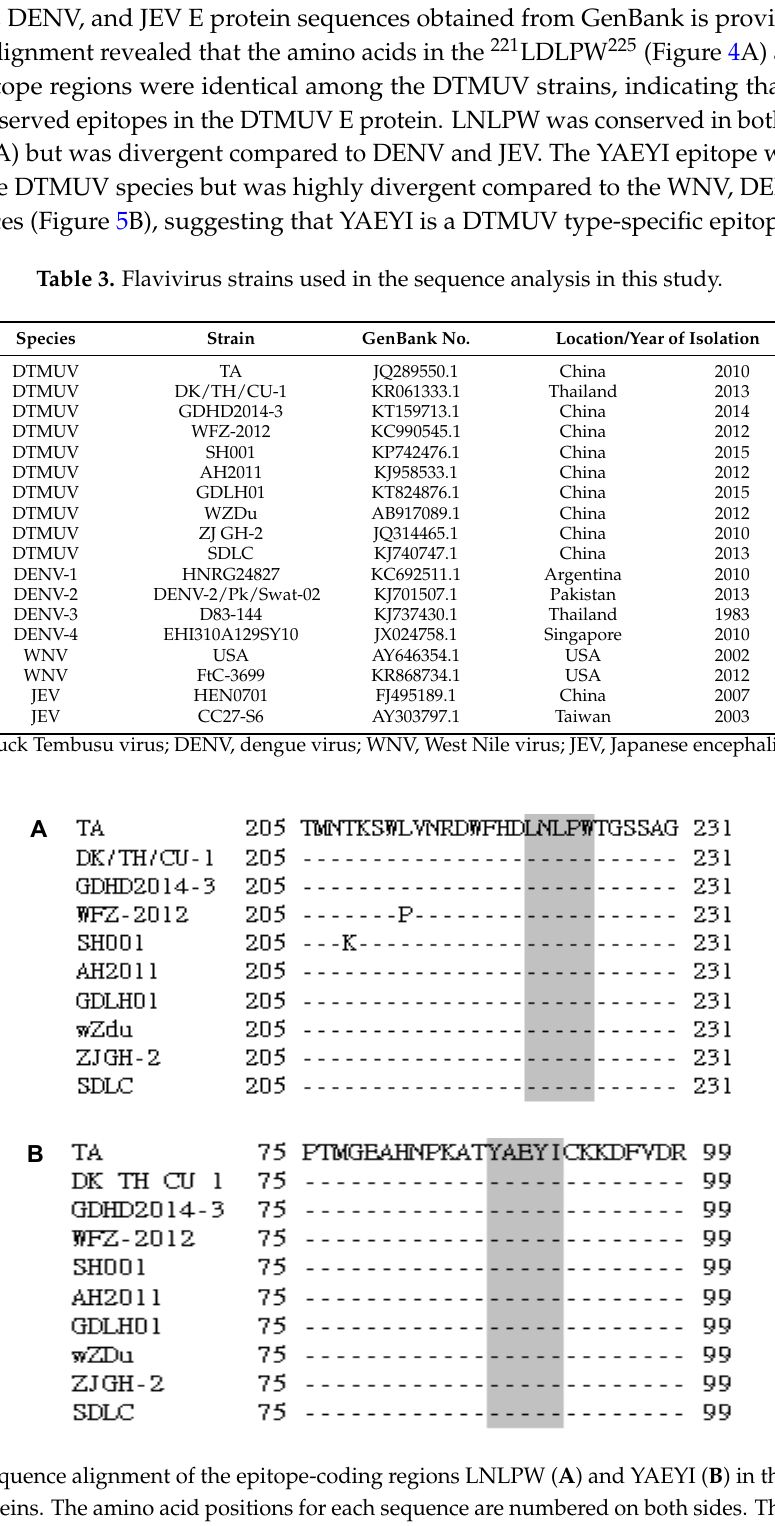
Table 3. Flavivirus strains used in the sequence analysis in this study.